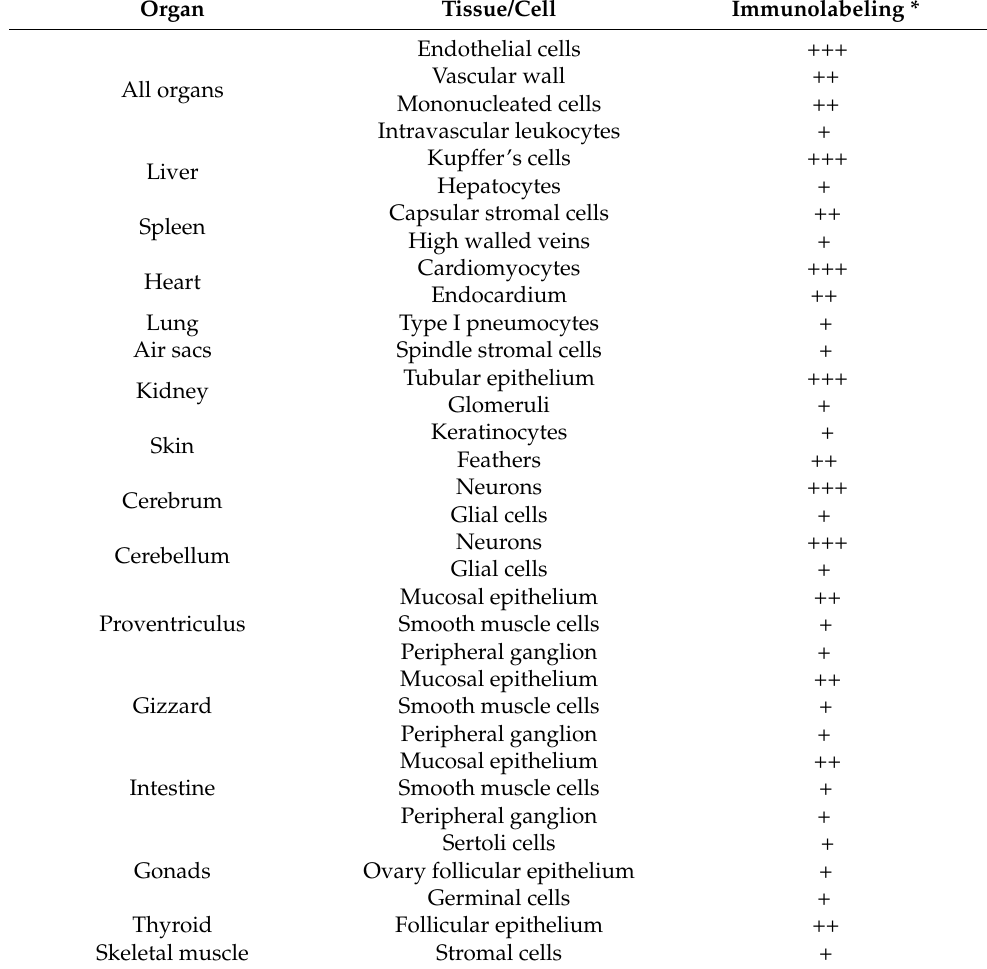
Table 4. Overview of the different involvement of the USUV-antigen in cell types in different organs. Organ